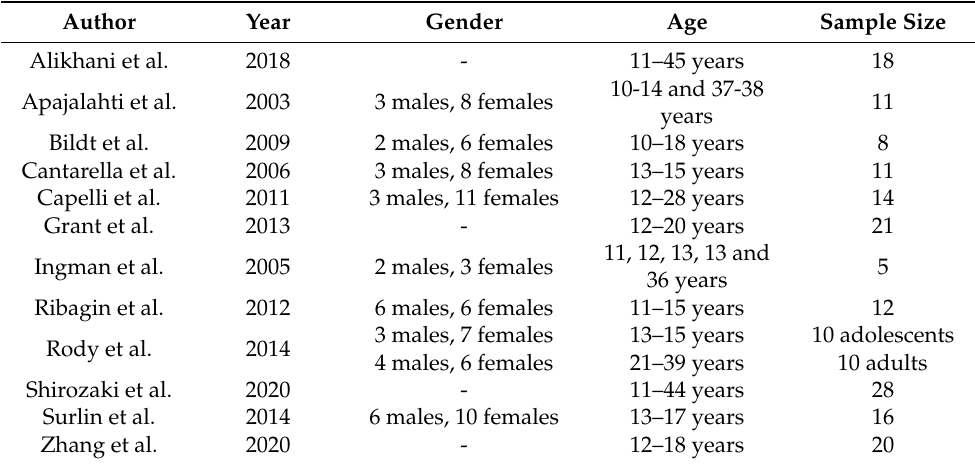
Table 5. Patient parameters of all included in vivo